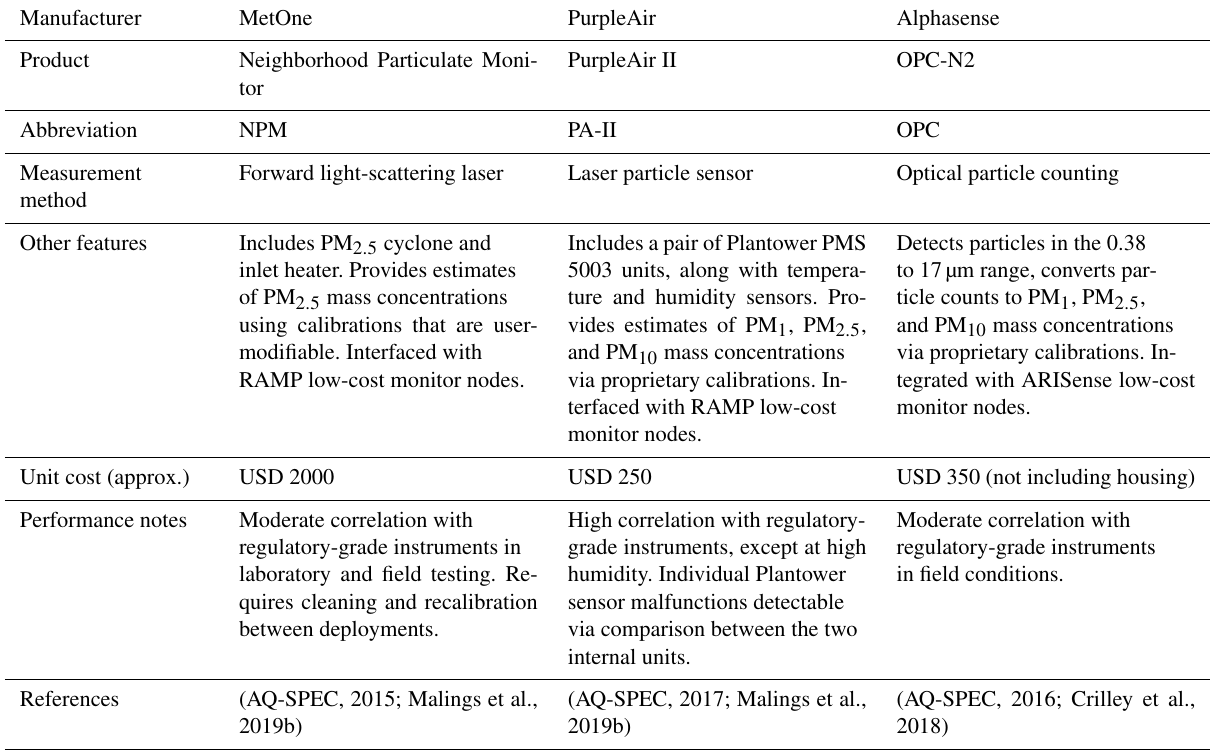
Table 1. Summary information for low-cost sensor systems utilized for this